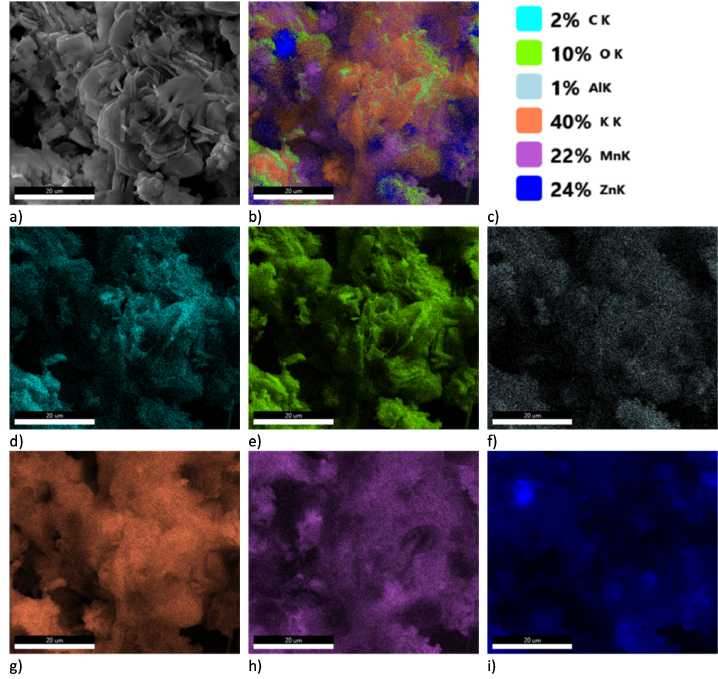
Figure A4. Result of SEM-EDS analysis for sample Zn4. ( a )—SEM picture; ( b )—EDS map; ( c )— weight concentration %; ( d )—EDS map for C; ( e )—EDS map for O; ( f )—EDS map for Al; ( g )—EDS map for K; ( h )—EDS map for Mn; ( i )—EDS map for